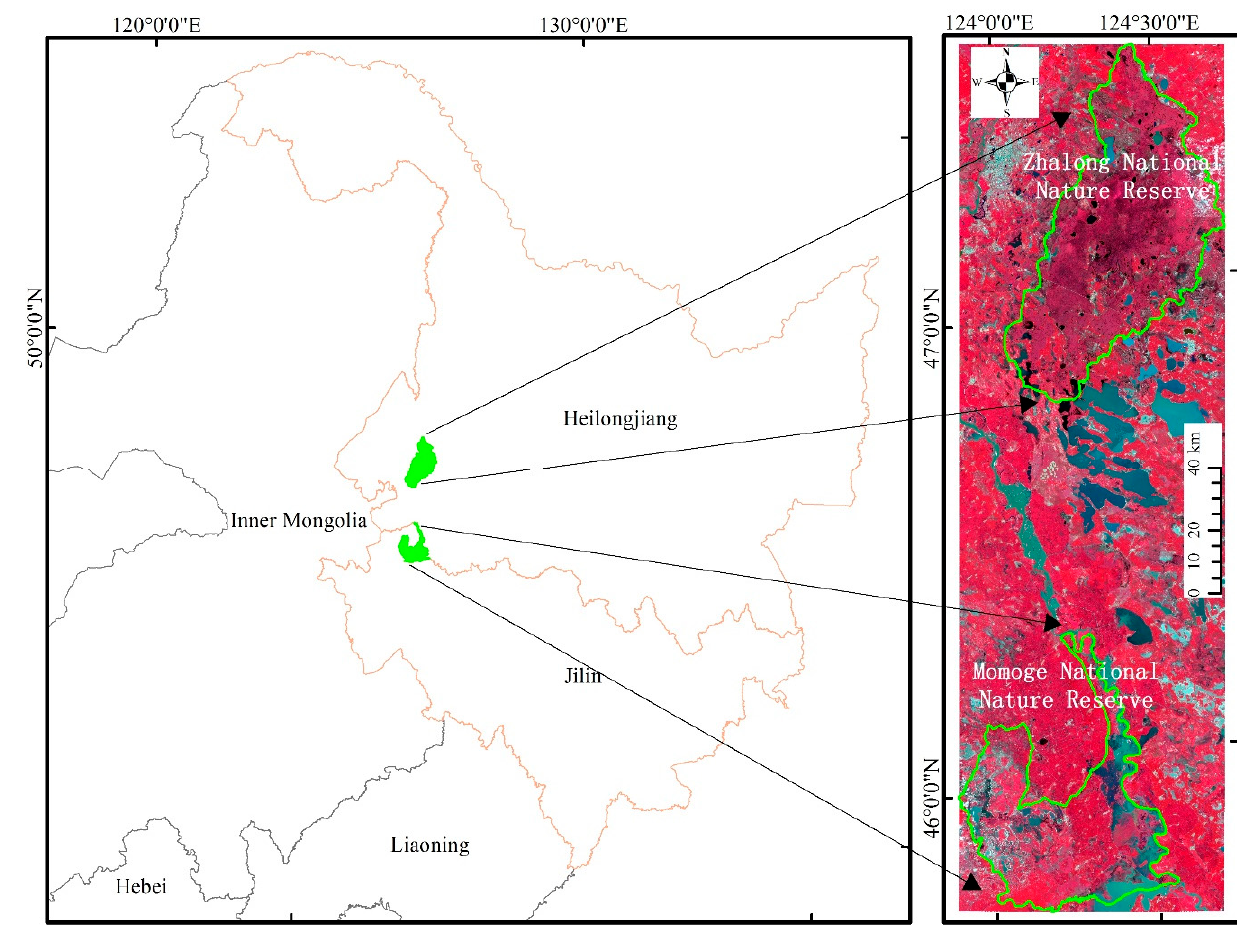
Figure 1. Location of study area.